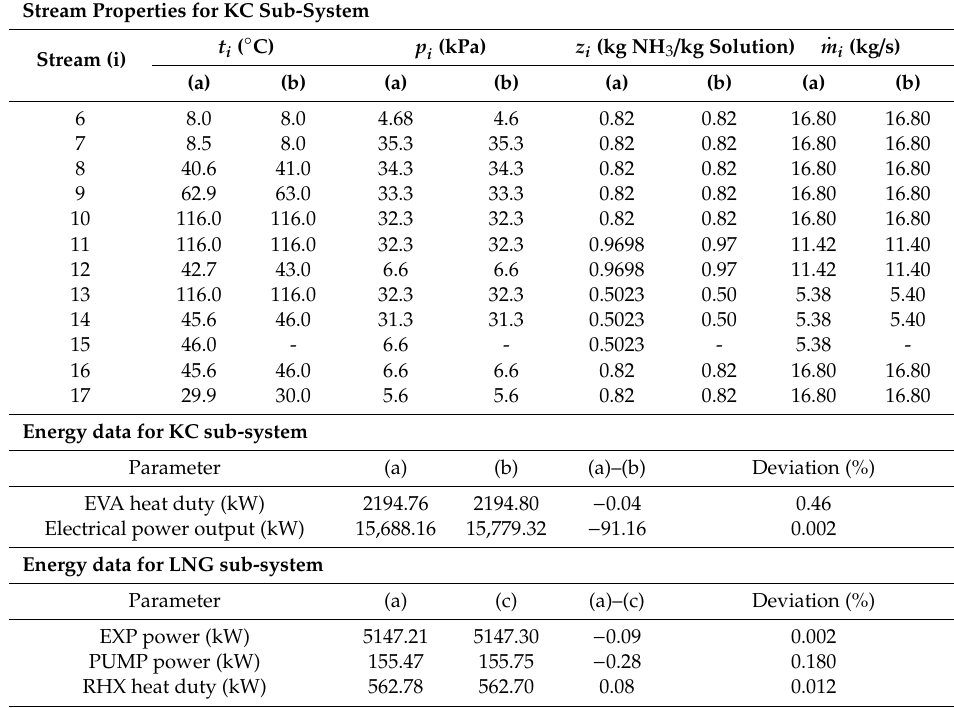
Table 2. Comparison of model outputs for the KC sub-system and LNG sub-system; (a) present study, (b) Ogriseck [31] and (c) Shi and Che